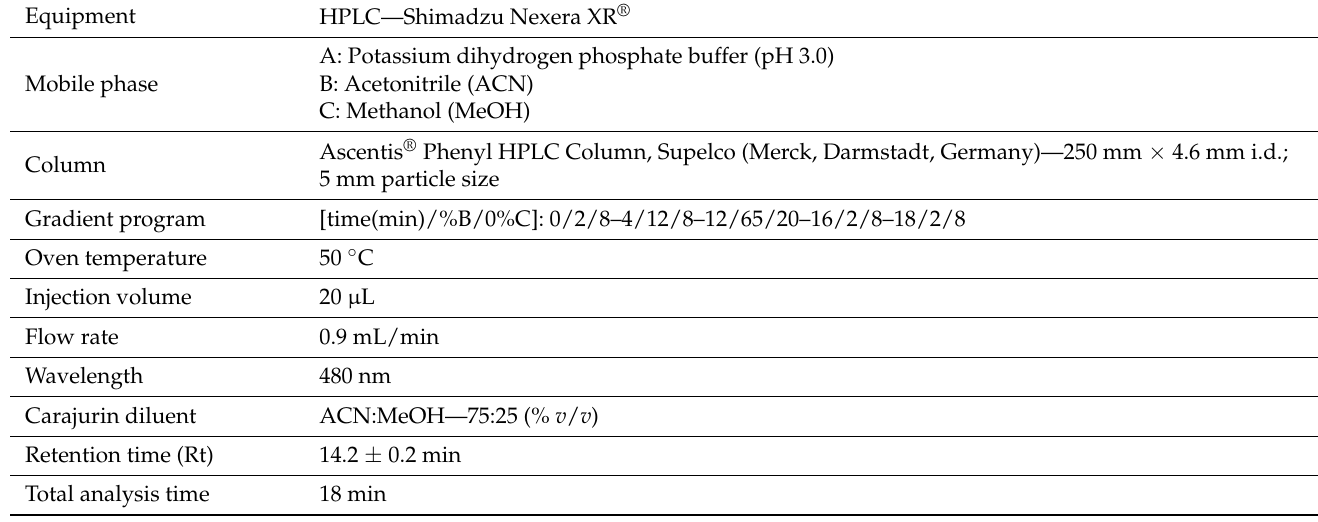
Table 2. Best analytical conditions to analyze carajurin by